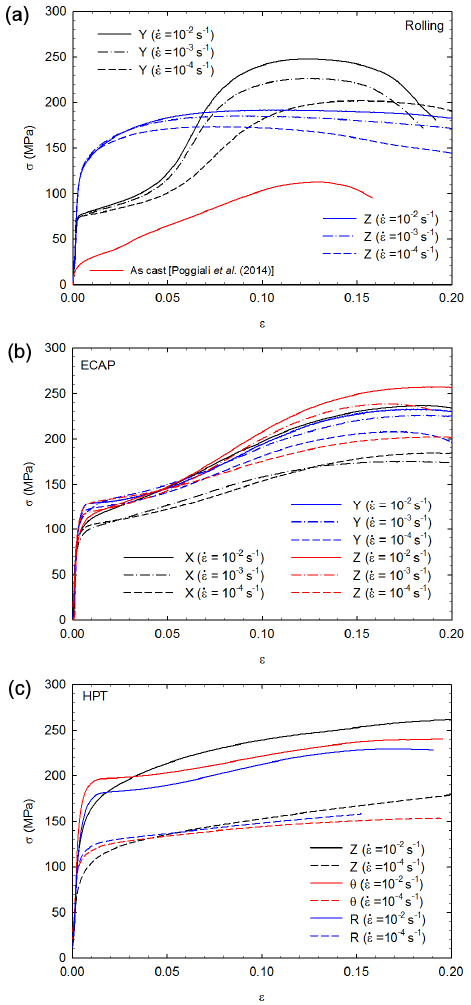
Figure 3. Compression stress vs. strain curves obtained at different loading directions and strain rates for the pure magnesium processed by ( a ) rolling, ( b ) ECAP, and ( c ) HPT.